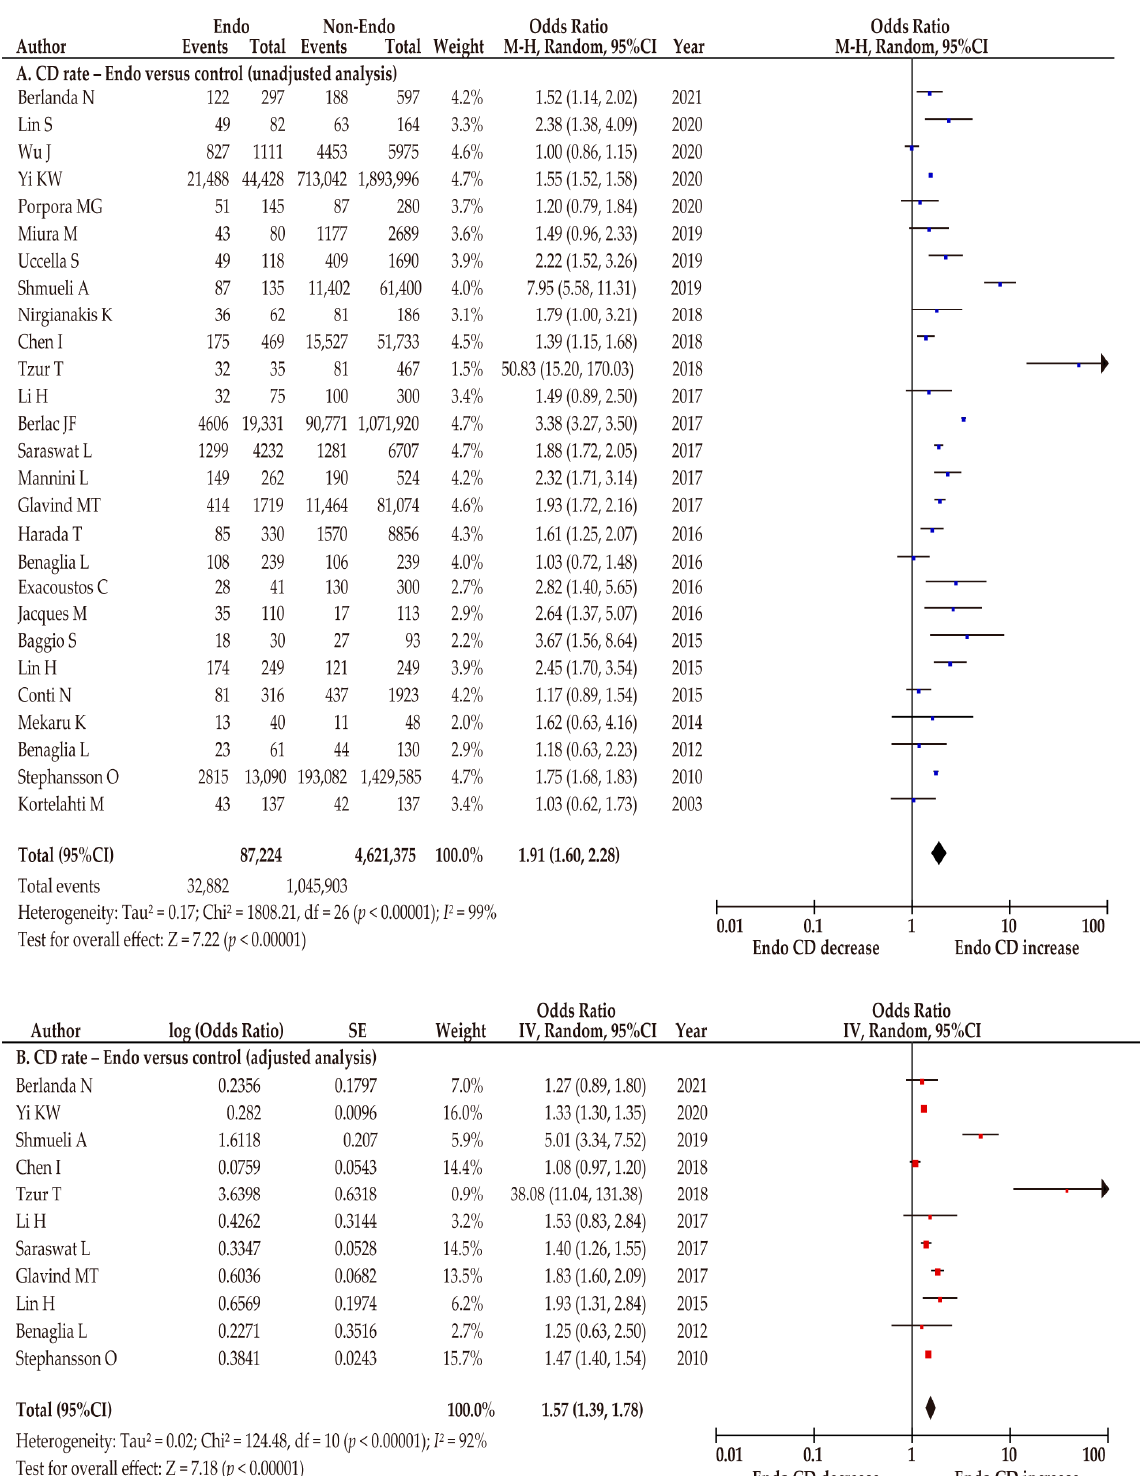
Figure 3. Meta-analysis of the effect of endometriosis on the CD rate. The pooled unadjusted ( A ) and adjusted ( B ) odds ratios for CD between women with and without endometriosis are shown. The forest plots were modified within the stratum according to year of publication and relative weight (%) of the study. Heterogeneity was considerable in both analyses (( A ), I 2 = 99%; ( B ), I 2 = 92%). Some values listed might differ slightly from the original values because the calculation was performed using Revman v5.4.1. Abbreviations: CD, cesarean delivery; CI, confidence interval; Endo,